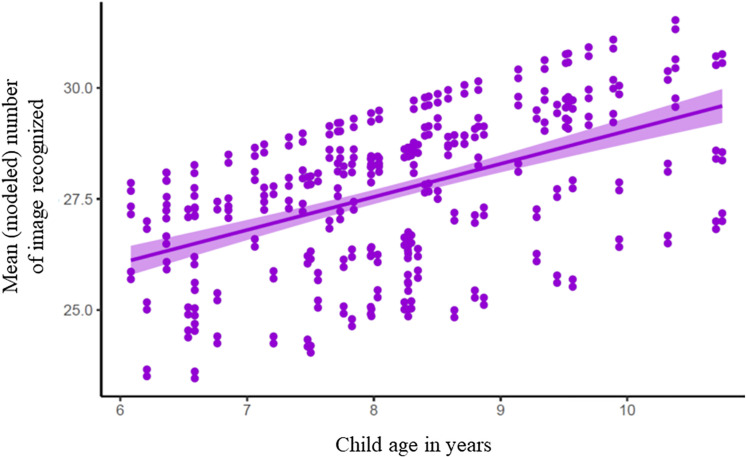
Accuracy of recognition of images. depicting high-ED. low-ED. and office supplies. increased with child age [P = 0.001; F(155) = 11.52. Cohen’s d = 0.44] and recognition increased by 2.7% (SE = 0.78) for each year increase in age in a sample of children ranging froni 6.08 to 10.75 years of age. Modeled slope and standard errors along with individual data points are values extracted from the model.